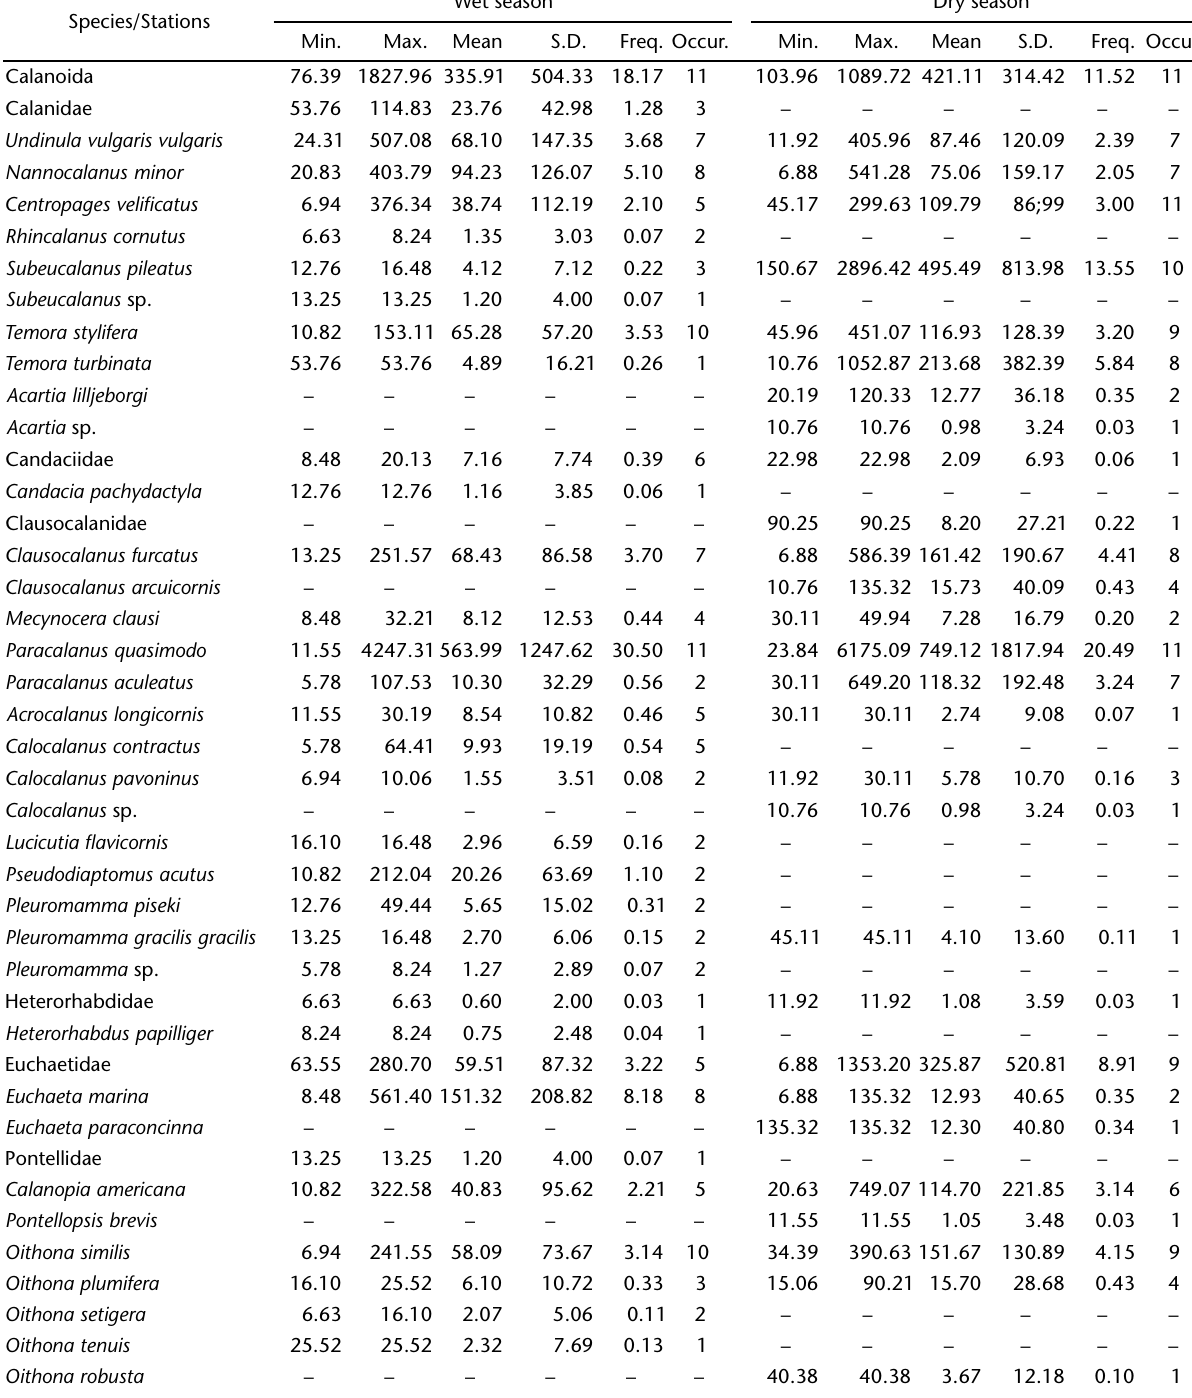
Table II. Minimum (Min.), maximum (Max.), mean, standard deviation (S.D.) (ind.m -3 ), frequency (%) and occurrence in samples of the copepod taxa sampled in the inner continental shelf adjacent to Camamu Bay.